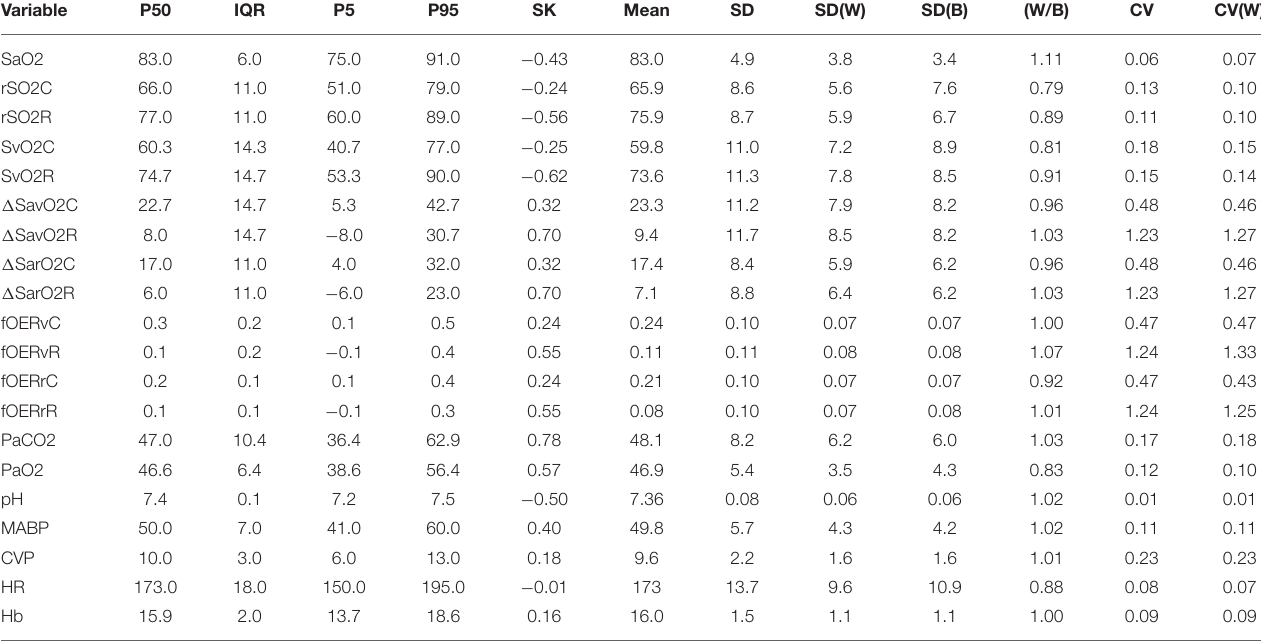
TABLE 3 | Summary of physiologic